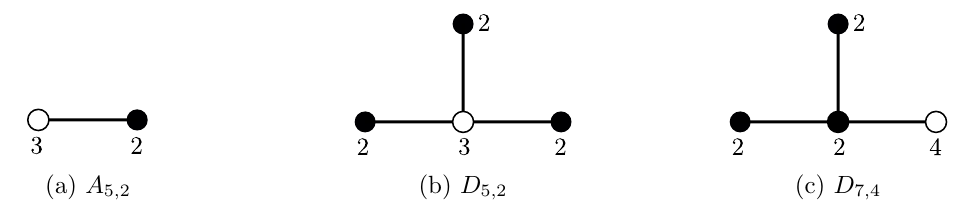
Figure 2. The generalized geometries considered in the text. Nodes denote two-cycles, a line connecting two nodes indicates that the cycles intersect each other transversely, and a number next to the node denotes (minus) its